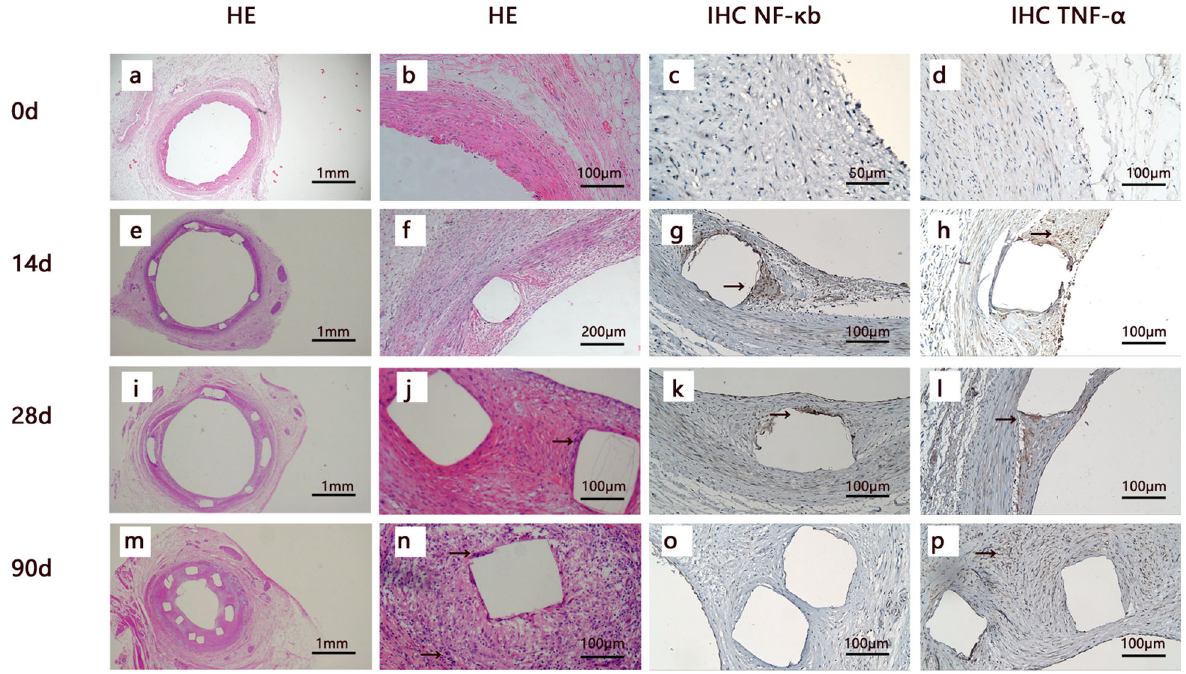
Fig. 1 Histology and immunohistochemistry of porcine coronary arteries implanted with PLLA-BVS follow-up to 90 d. The images were shown by HE staining (from left to right, fi rst and second columns) and immunohistochemistry staining (third and fourth columns) of the coronary arteries after implantation for 0 d ( a – d ), 14 d ( e – h ), 28 d ( i – l ), 90 d ( m – p ), respectively. White squares in all pictures indicate components of PLLA stent, macrophages were indicated by black arrows at 28 and 90th day ( j , n ) in HE stain image, and positive immunohistochemistry staining of NF- κ b/ TNF- α were indicated by black arrows at 14 d, 28 d and 90 d ( g , h , k , l , p ).